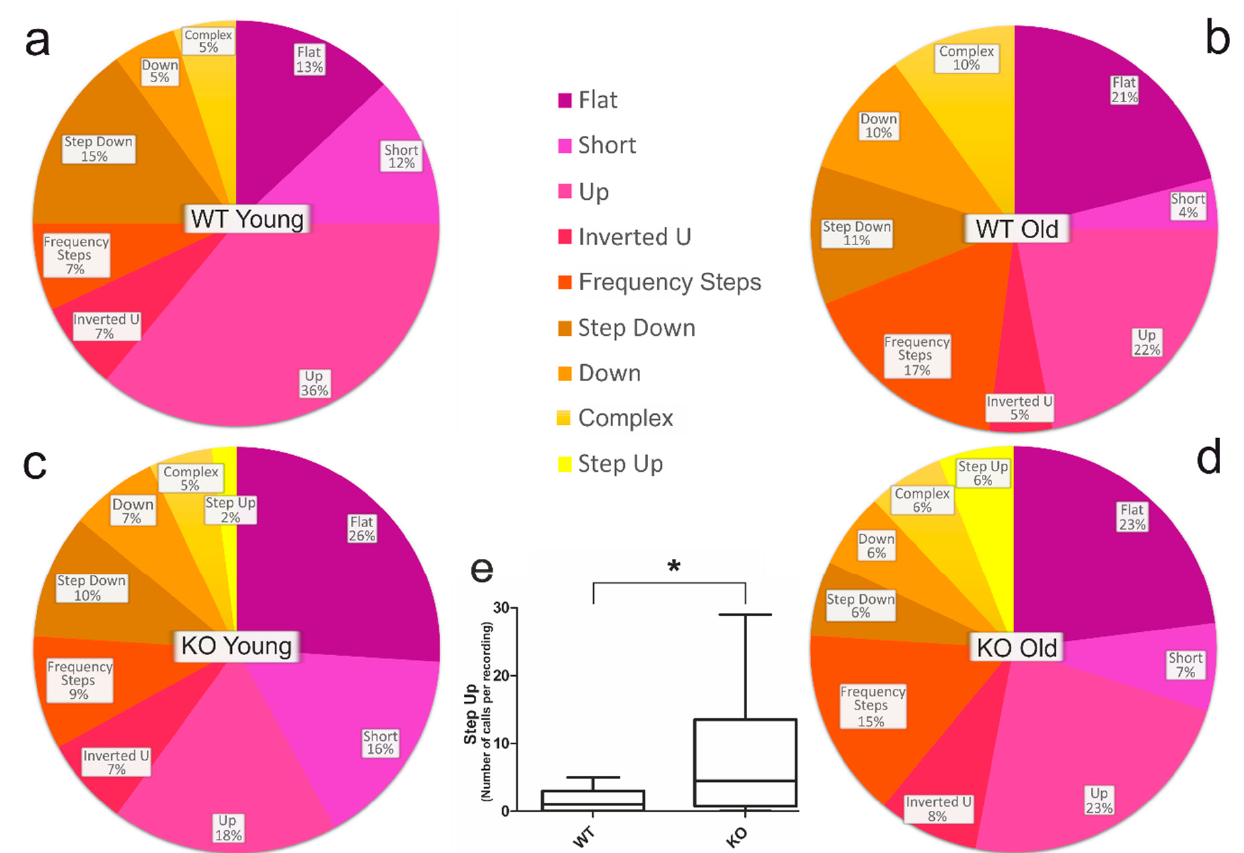
Figure 2. Relative number of calls. ( a ) Distribution of calls of young WT in percent ( n = 1658). ( b ) Distribution of calls of old WT in percent ( n = 3326). ( c ) Distribution of calls of young KO in percent ( n = 238). ( d ) Distribution of calls of old KO in percent. ( n = 1271). Calls with less than 1% (U) are excluded in all pie charts. ( e ) EUR number of Step Up calls: comparison of the total number of Step Up calls per recording ( p = 0.0146). * p < 0.05.